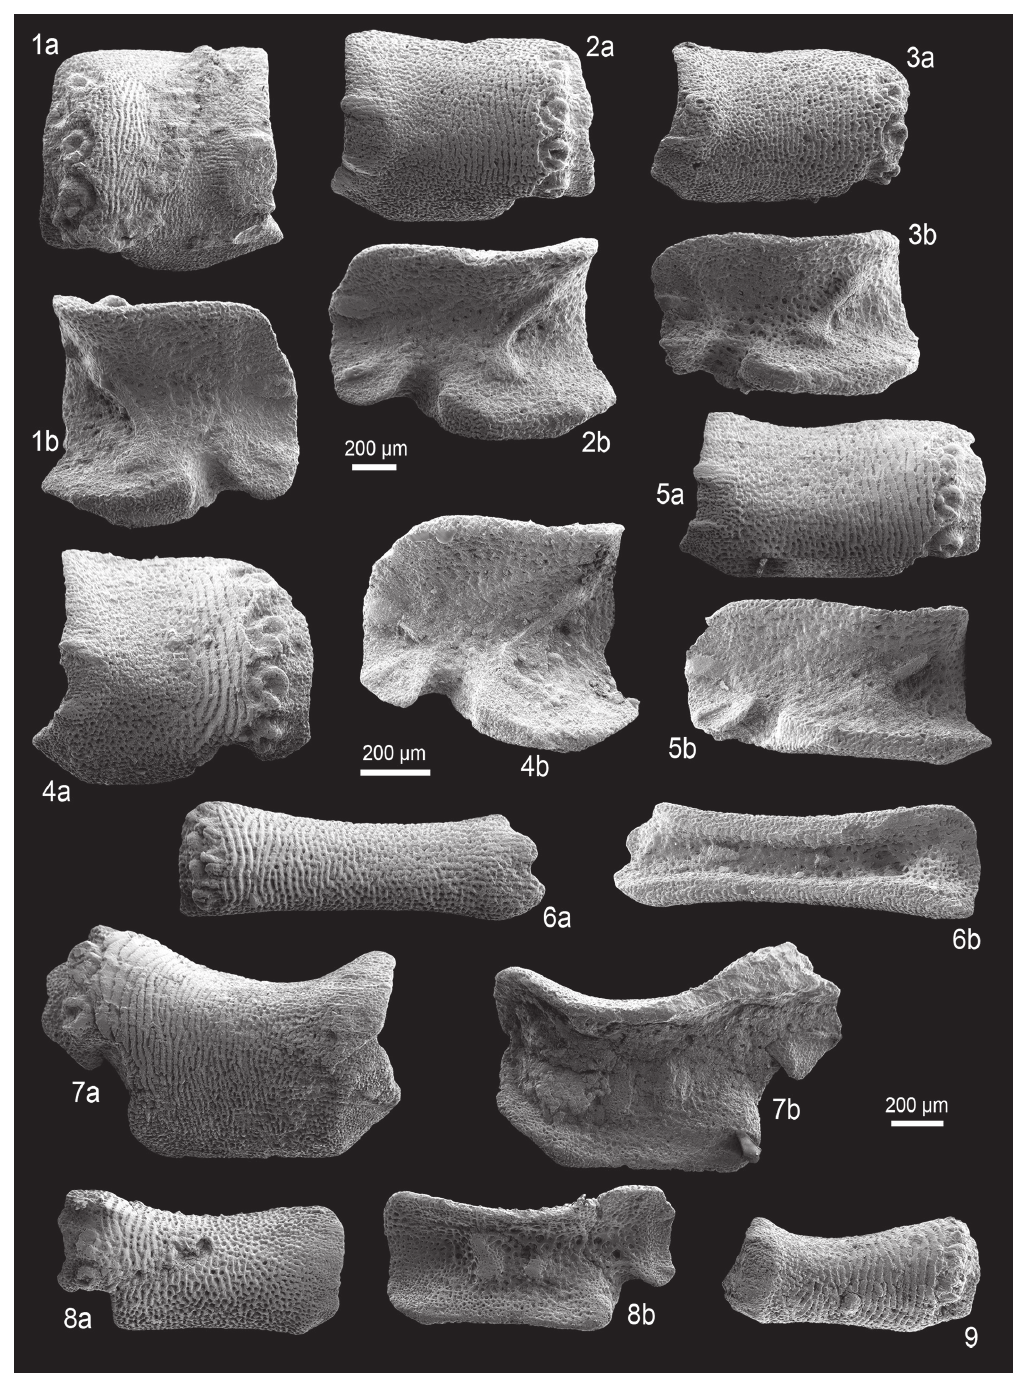
Fig. 30. Fossil lateral arm plates (LAPs) of ophiacanthid brittle stars in external (a) and internal (b) views. 1-3. Dermacantha sp. nov. innom. from the Bajocian-Bathonian boundary of Touert, France. 1. GZG.INV.78714, proximal LAP. 2. GZG.INV.78715, median LAP. 3. GZG.INV.78716, distal LAP. 4-6. Dermacantha carli gen. et sp. nov. from the late Oxfordian (Late Jurassic) of the Plettenberg, Germany. 4. GZG.INV.78718 (holotype), proximal LAP. 5. GZG.INV.78719 (paratype), median LAP. 6. GZG. INV.78720 (paratype), distal LAP. 7-9. Ishidacantha hirokoae gen. et sp. nov. from the middle Toarcian (Early Jurassic) of Le Clapier, France. 7. GZG.INV.78723 (holotype), proximal LAP. 8. GZG.INV.78724 (paratype), median LAP. 9. GZG.INV.78725 (paratype), distal LAP. One common scale bar per